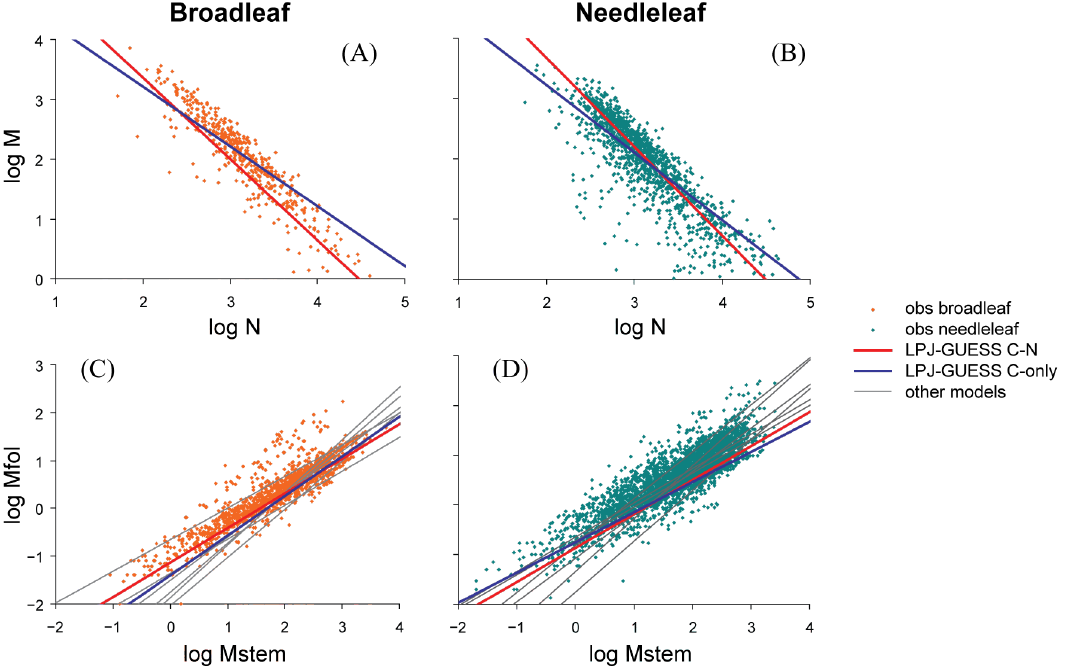
Fig. 5. Component biomass allometry for broadleaf-dominated (A, C) and needleleaf-dominated (B, D) grid cells from C–N and C-only simulations superimposed on data for forest stands from the Cannell (1982) and Usoltsev (2001) databases. Curves are fitted to model data from the 0.5 ◦ × 0.5 ◦ grid cells encompassing stand coordinates from the observed databases. Allometric relationships from the land surface models considered by Wolf et al. (2011) (grey curves) are reproduced from that paper. N =tree population density (ha − 1 ) ; M =total biomass of average tree (kg); M fol =foliage biomass of average tree (kg); M stem =stem biomass of average tree